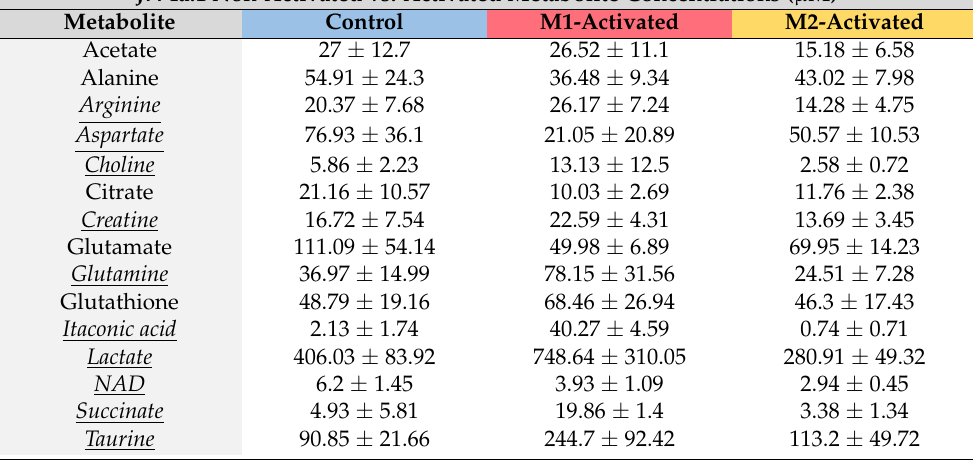
Table 1. Metabolite concentrations for control (blue), M1-activated (red), and M2-activated